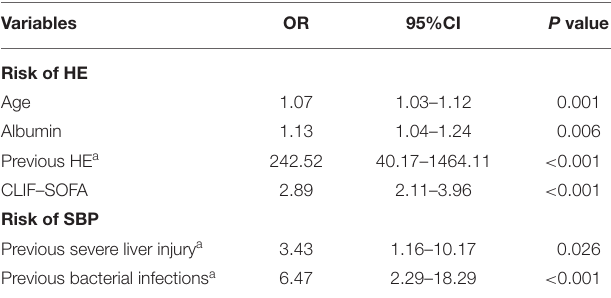
TABLE 3 | Risk factors associated with HE and SBP in decompensated cirrhosis patients.